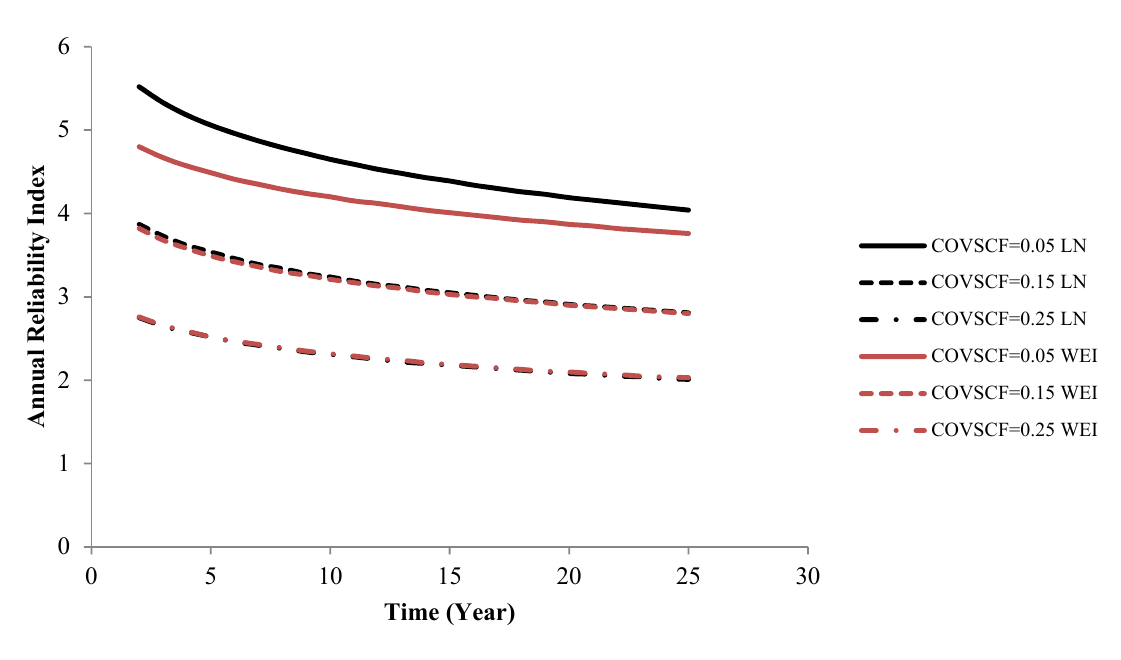
Figure 9. Annual reliability index for different uncertainty models for X SCF . Test D21 T150 R = −